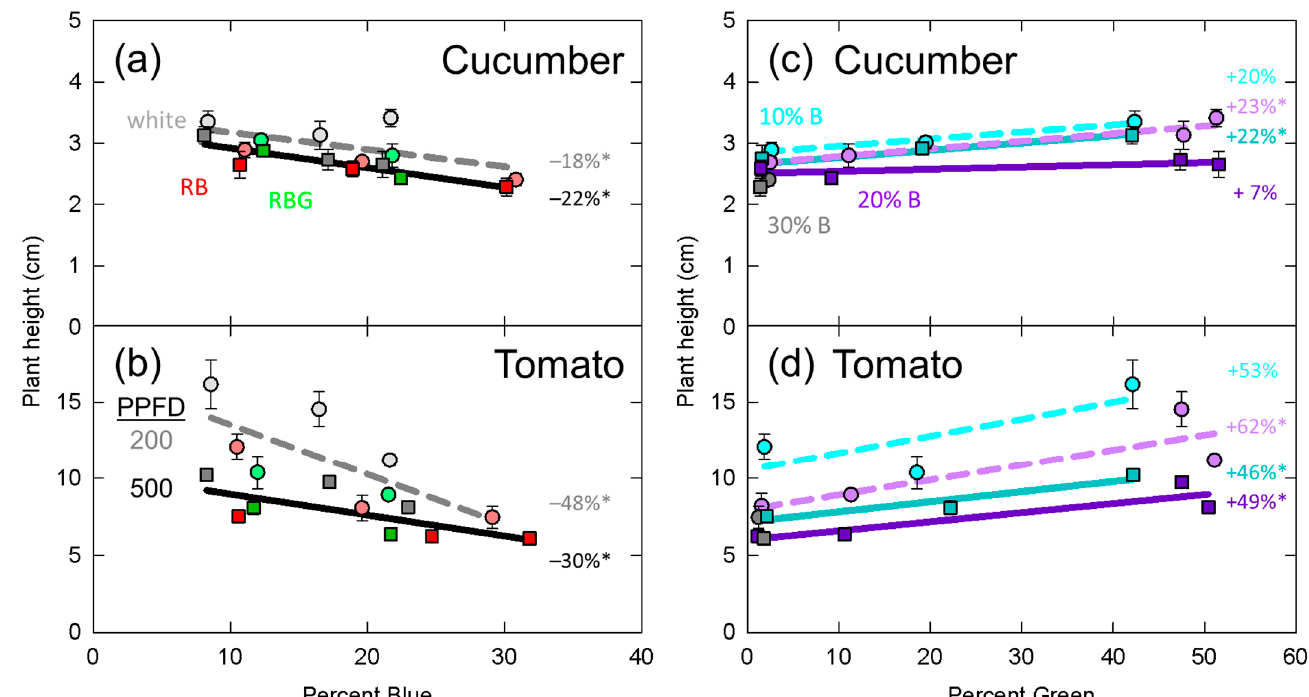
Figure 6. Effect of percent blue on plant height in ( a ) cucumber and ( b ) tomato; and effect of green photons on plant height in ( c ) cucumber and ( d ) tomato. * represents a significant effect of percent blue or percent green at the p < 0.05 level. See Figure 3 for the meaning of specific labels. Error bars represent normalized standard error of n = 3 replicates.